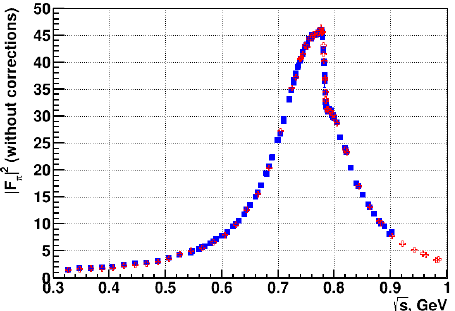
Figure 4. Preliminary results on F 2 from CMD- π 3. Open crosses – separation done using the calorimeter information, filled squares – using particle momentum. Some additional corrections, common to two methods, are not